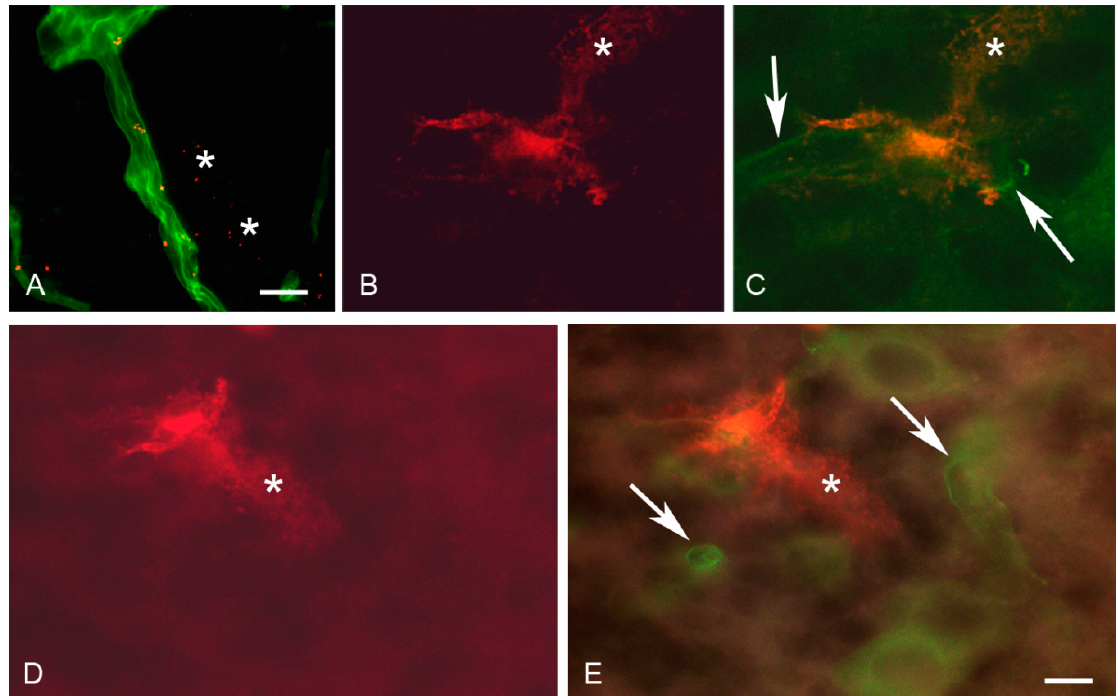
Figure 5. Brain distribution of magnetic OX26 immunoliposomes following in situ perfusion and the application of external magnetic force. Images are from rats which received 10 µg/g bodyweight of magnetic OX26 immunoliposomes while being subjected to an externally placed magnet. ( A ) Magnetic OX26 immunoliposomes (red) are present both inside and beyond (asterisks) an intraparenchymal brain capillary, with its boundaries indicated by laminin (green). ( B , C ) Detection of magnetic OX26 immunoliposomes’ (red) leakage from a brain capillary using confocal imaging. ( B ) Single detection of magnetic OX26 immunoliposomes. ( C ) Merging magnetic OX26 immunoliposomes (red) with laminin (green, arrows) reveals the presence of magnetic OX26 immunoliposomes beyond the boundaries of the brain capillary ( B , C , asterisks ). ( D , E ) Detection of magnetic OX26 immunoliposomes’ (red) leakage from a different brain capillary than those seen in B and C. The extravasated magnetic OX26 immunoliposomes (asterisks) do not co-distribute with laminin (green, arrows). Scale bars = 20 µm ( A ), 5µm ( B – E ).